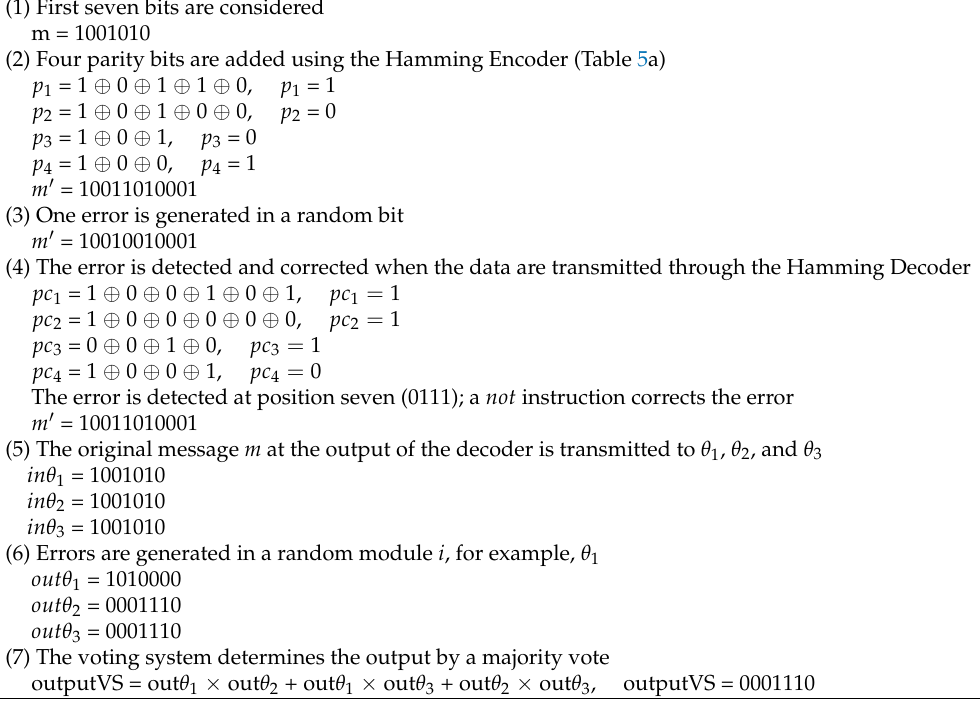
Table 4. Error detection and correction algorithms execution.